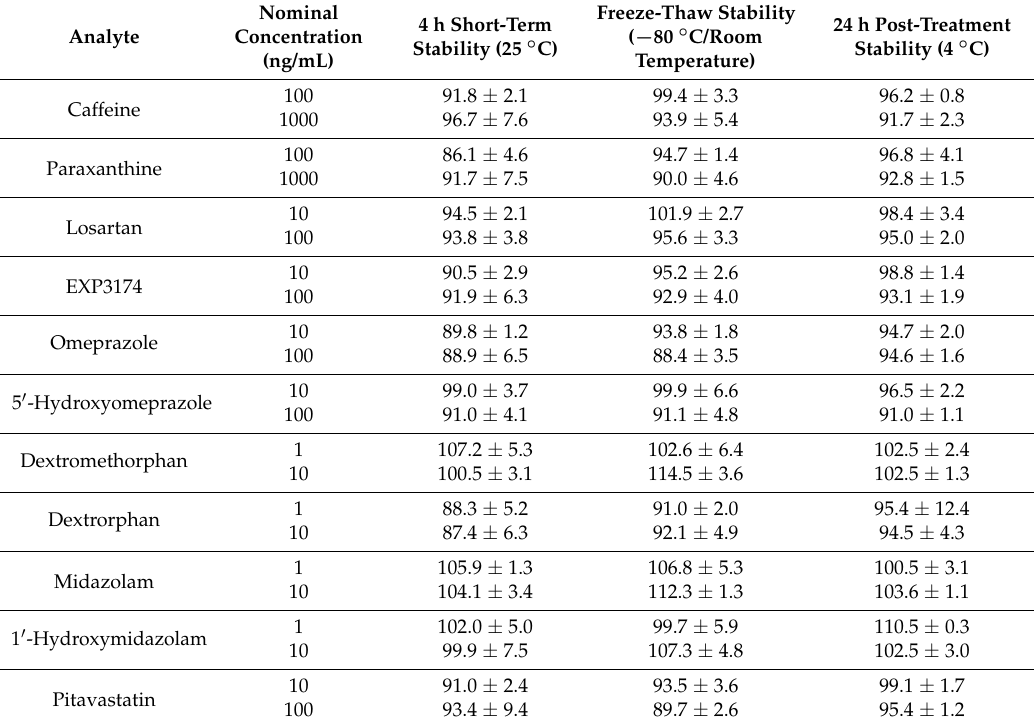
Table 4. Short-term (4 h), freeze–thaw (three cycles), and post-treatment (4 ◦ C, 24 h) stability results for all probe drugs and their metabolites in human plasma. Results are expressed as concentration mean ±